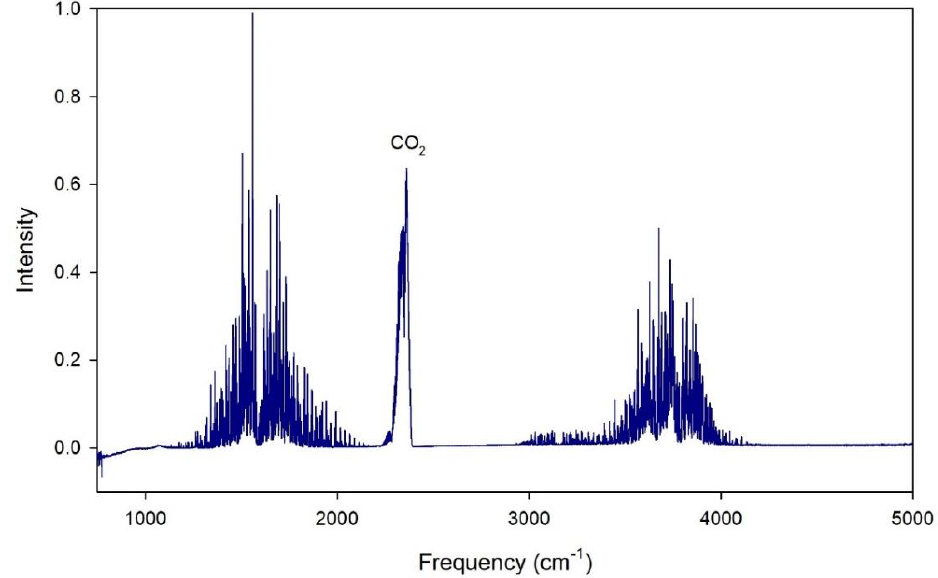
Figure 2. Typical spectral output of a Covid-19 positive patient.